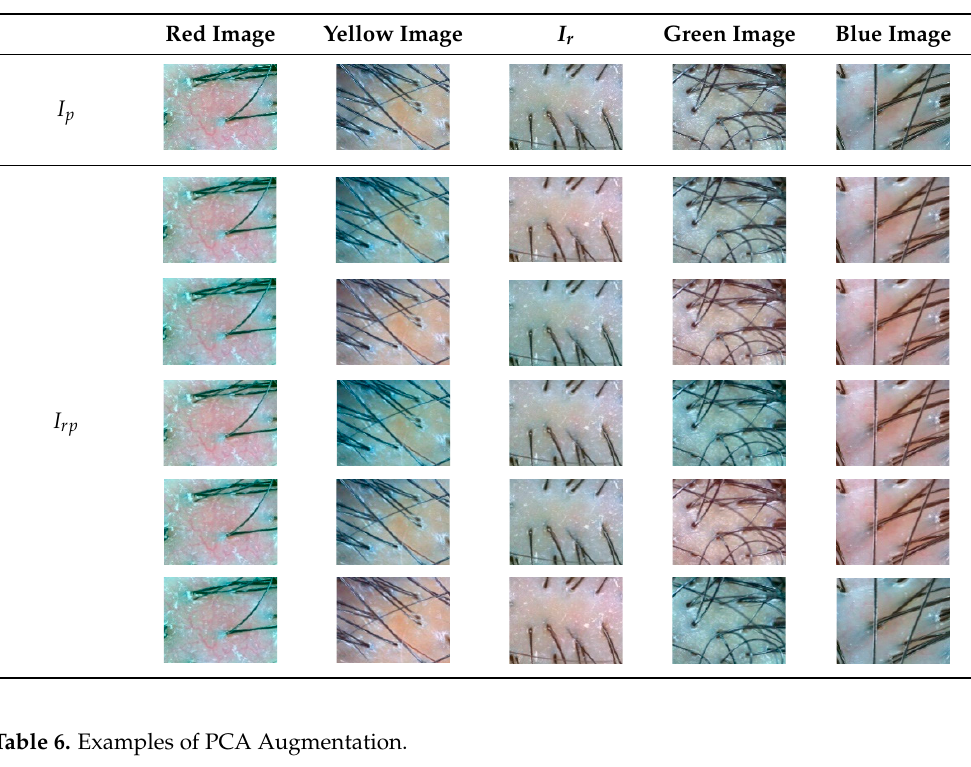
Table 5. Examples of red addition and augmentation.